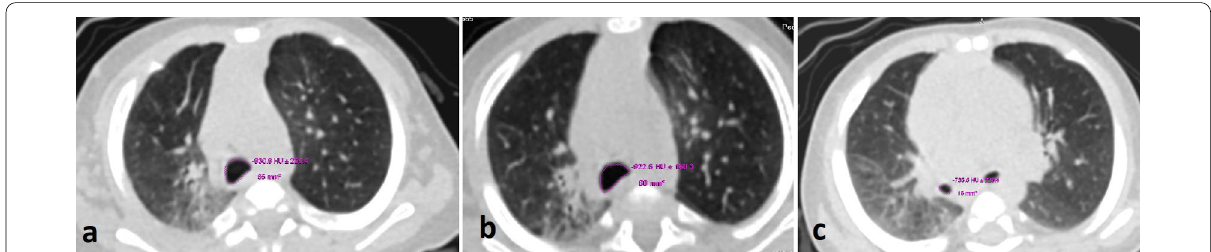
Fig. 1 Cross-sectional area measurements by cine CT. Three predefined areas were selected for measurement at end-inspiratory phase: a at aortic arch level, b at carina and c at bronchus intermedius. Measurements were obtained at lung window setting by manually drawing ROI outlining airway lumen at end-inspiratory phase. Double oblique method was used to ensure true axial section of the airway measured. The same measurements at the same levels were repeated during end-expiratory phase (not shown) to calculate the percentage of airway